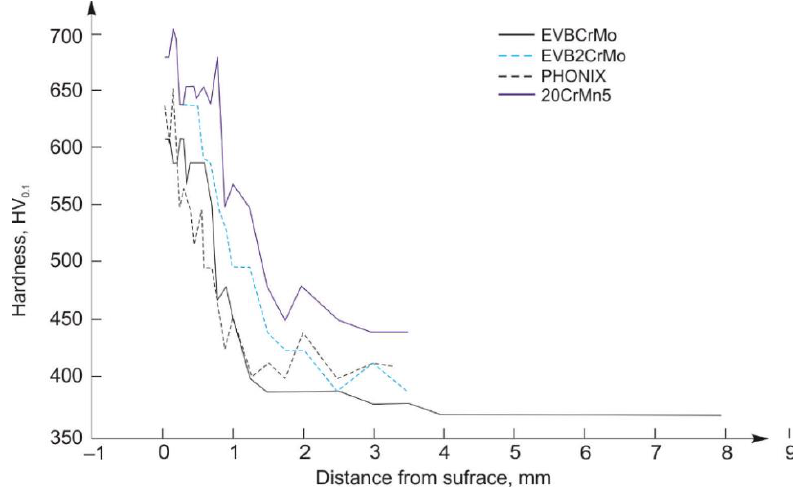
Figure 16. Hardness distribution diagram of samples hard-faced with “ soft ” filler metals.